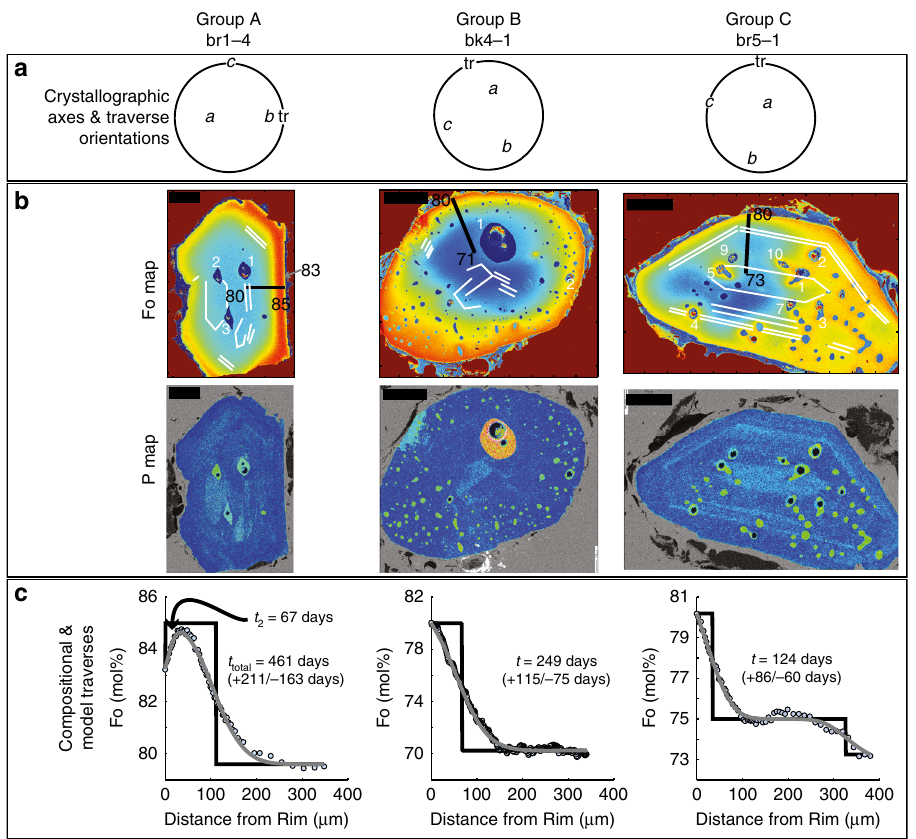
Fig. 1 Key datasets for representative crystals from each crystal group. a EBSD results showing the crystallographic and traverse orientation projected on the lower hemisphere ( a, b, c , crystallographic axes, tr = traverse). b X-ray maps of %Fo (numbers in the map; red colour is higher %Fo than blue) and phosphorous abundance (brighter zones are higher concentrations). In the %Fo maps black lines indicate the traverse location, and white lines indicate regions of elevated phosphorous; these crystals were imbedded in indium. The outlined numbers identify speci fi c melt inclusions. Some melt inclusions are open to the surrounding matrix melt (e.g., crystal br 5-1) as evidenced by the host olivine around some melt inclusions that shows patchy zoning. We refer to these as open melt inclusions. c Electron microprobe and calibrated BSE traverses of Fo (light dots), initial conditions used for the diffusion model (black), and models pro fi les (grey). We note these crystals are tilted, but pro fi le locations were placed perpendicular to the tilt direction to minimize this effect. The times are shown in each crystal